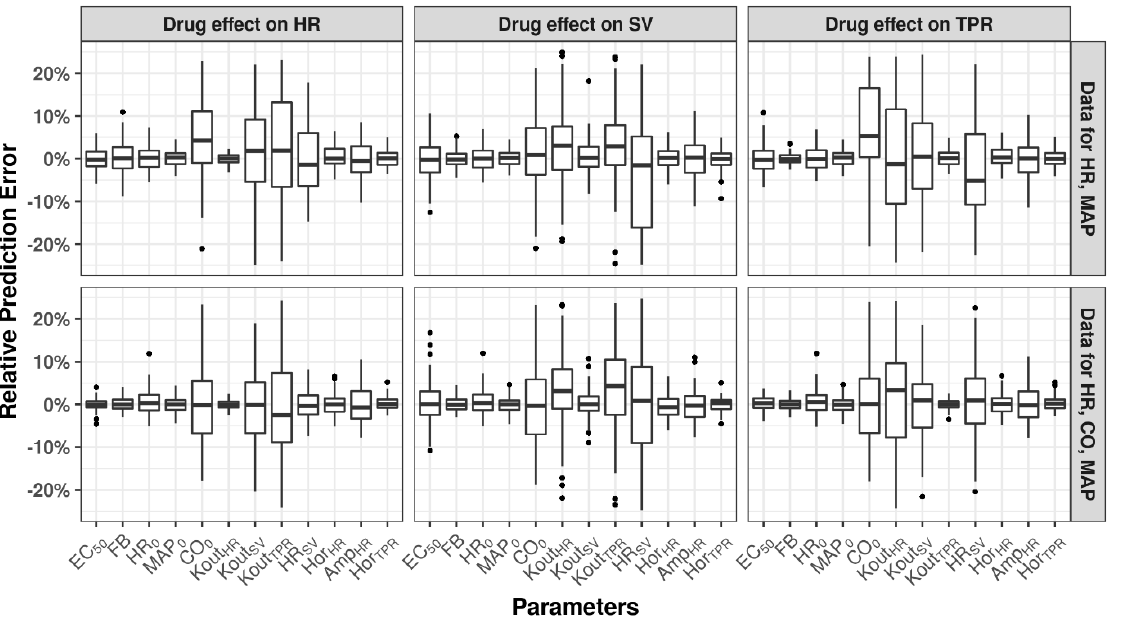
Figure 3. Identifiability of drug- and system-specific parameters. HR: heart rate; CO: cardiac output; SV: stroke volume; TPR: total peripheral resistance; MAP: mean arterial pressure. Relative prediction errors after simulation and re-estimation (SSE) analysis using observations for HR and MAP ( top ) or observations of HR, CO, and MAP ( bottom ) following three ascending doses. EC 50 : the concentration at which half of maximum effect is achieved; FB: regulatory feedback effect from MAP to HR, SV, and TPR; HR 0 : baseline value of HR; MAP 0 : baseline value of MAP; CO 0 : baseline value of CO; Kout HR : dissipation rate of HR; Kout SV : dissipation rate of SV; Kout TPR : dissipation rate of TPR; HR SV : direct effect constant between HR and SV; Hor HR : horizontal displacement of circadian rhythm of HR; Amp HR : amplitude of circadian rhythm of HR; Hor TPR : horizontal displacement of circadian rhythm of TPR.